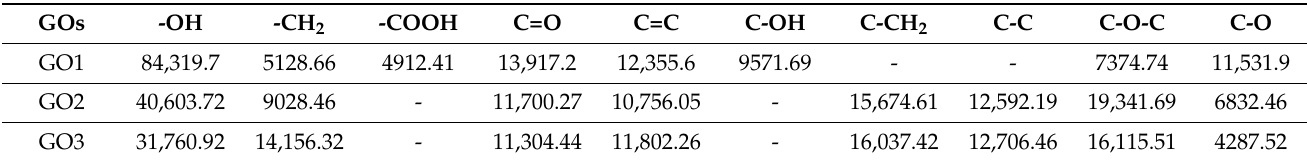
Table 3. Area under the curve of GO